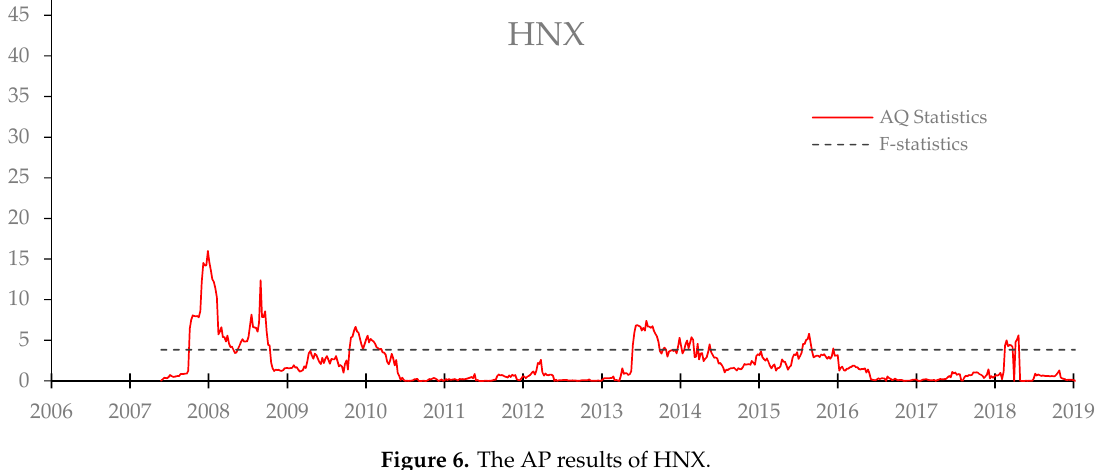
Figure 6. The AP results of HNX.